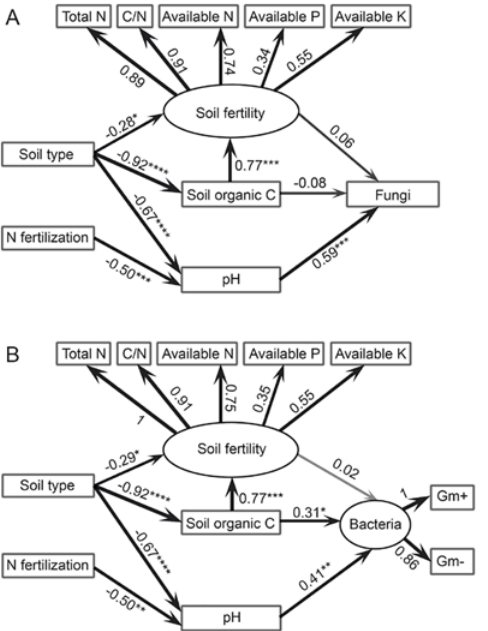
Fig 3. The structural equation model showing the direct and indirect effects of soil type and N fertilization on fungi (A) and bacteria (B). Soil fertility index is a patent variable indicated by total N, C/N ratio, available N, P, and K. Bacteria is indicated by Gram-positive (Gm+) and Gram-negative (Gm – ) bacteria. The width of arrow indicates the strength of the standardized path coefficient ( * , P < 0.05; ** , P < 0.01, *** , P <